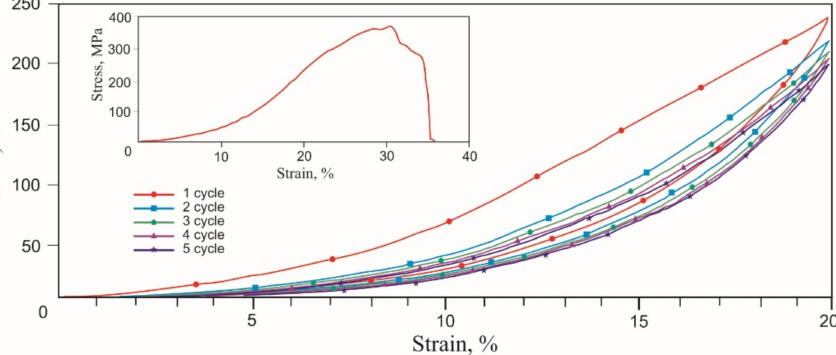
Figure 6. Engineering tensile stress-strain curves of the skin 5 loading-unloading cycles and uniaxial tension to rupture